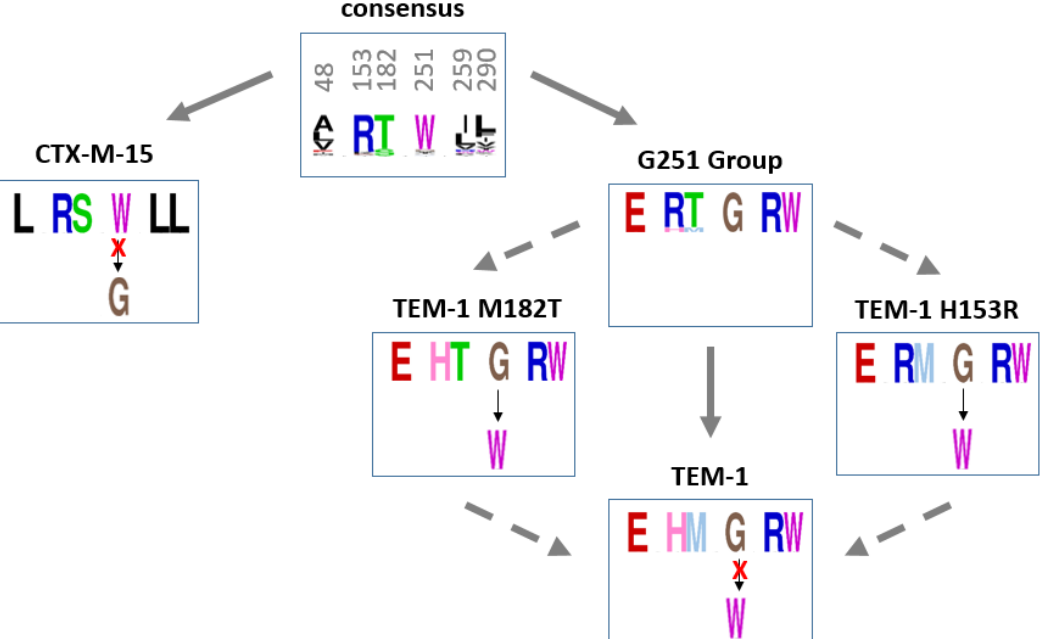
Figure 6. Steps of entrenchment of the residue G251 in TEM-1. The 3 sites (48, 259, and 290) that coevolve with G251 and two sites involved in compensating mutations (153 and 182) are represented beside site 251. The ability of each beta-lactamase to tolerate W251 or G251 is represented if it was validated experimentally.